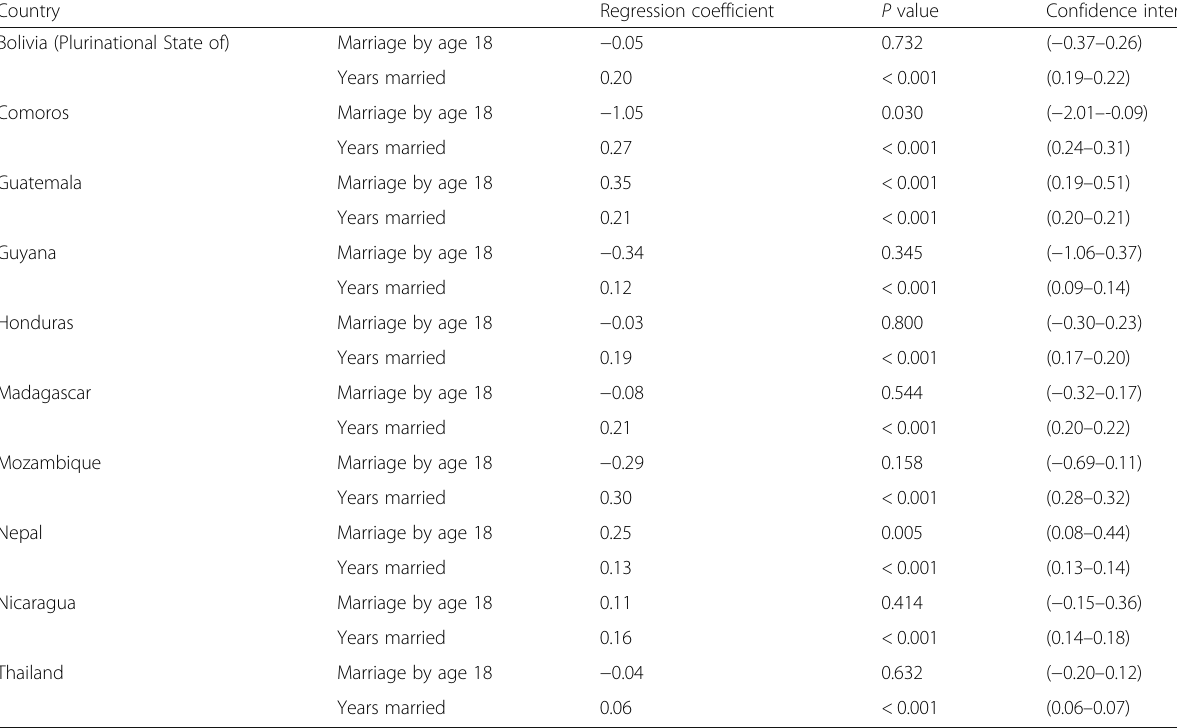
Table 7 Results from linear regression analysis adjusting for the number of years married: Factors associated with the number of children fathered among currently married men aged 20 – 49 Country Regression coefficient P value Confidence interval Bolivia (Plurinational State of)